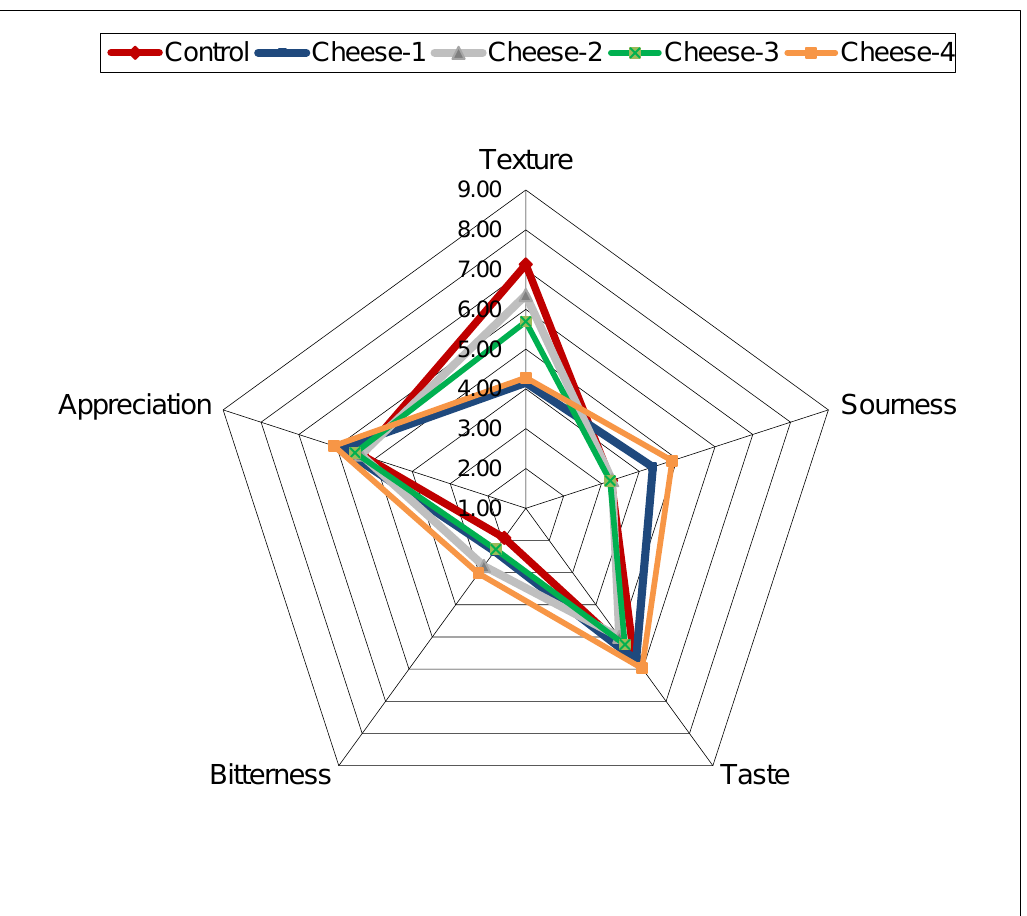
Figure 3. Spider plot from the quantitative descriptive analysis (QDA) carried out between lab scale control cheese and four commercial Crescenza cheeses from retail.